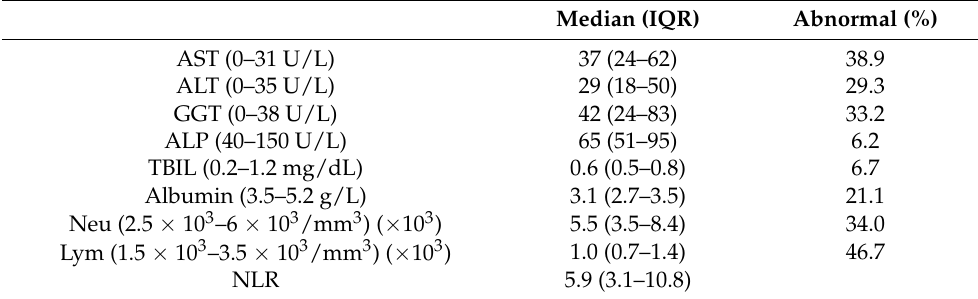
Table 2. Labolatory parameters of patients on admission n = 2109.